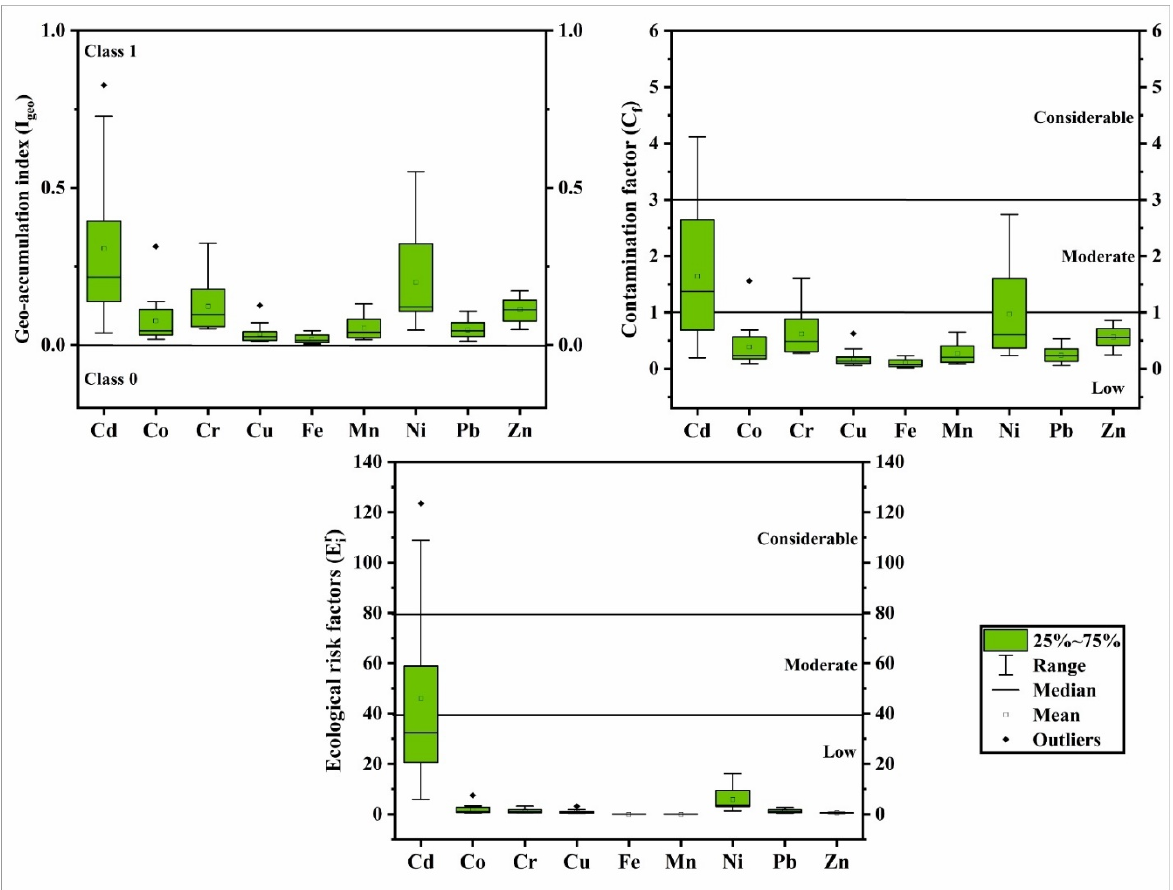
Figure 5. Boxplots of I geo , C f , and E (cid:2919)(cid:2928) values.